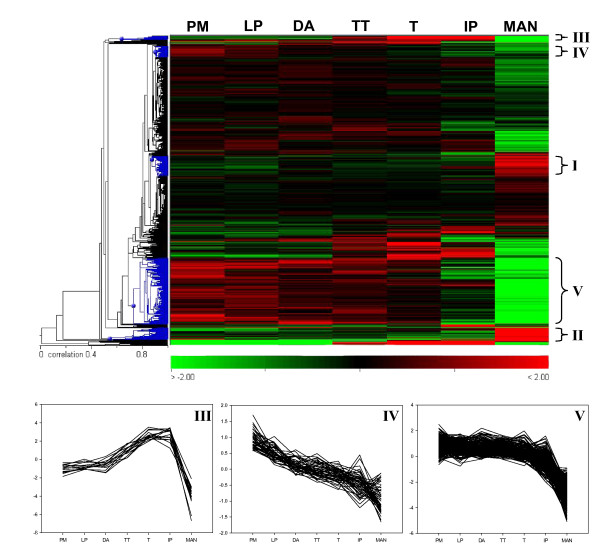
Hierarchical clustering of 1,350 meiotically-regulated transcripts. The expression profiles of 1,350 transcripts (rows) were grouped across seven staged anthers (columns); pre-meiosis (PM), leptotene to pachytene (LP), diplotene to anaphase I (DA), telophase I to telophase II (TT), tetrads (T), immature pollen (IP) and mature anthers (MAN) (averages shown). Clusters of interest (described in text) are highlighted in blue and labelled I and II (pollen clusters); III, IV and V (meiotic clusters). The Y-axis for cluster groups III, IV and V is centered, log base 2, RMA normalized values.